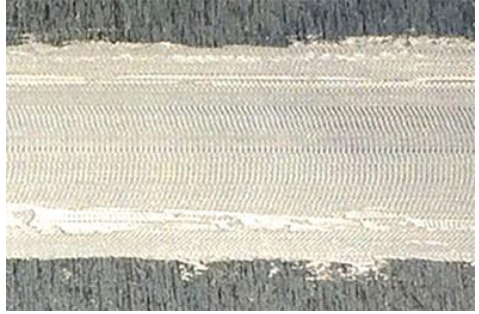
Figure 3. General appearance of the aluminium weld surface using an uncoated and unpolished steel